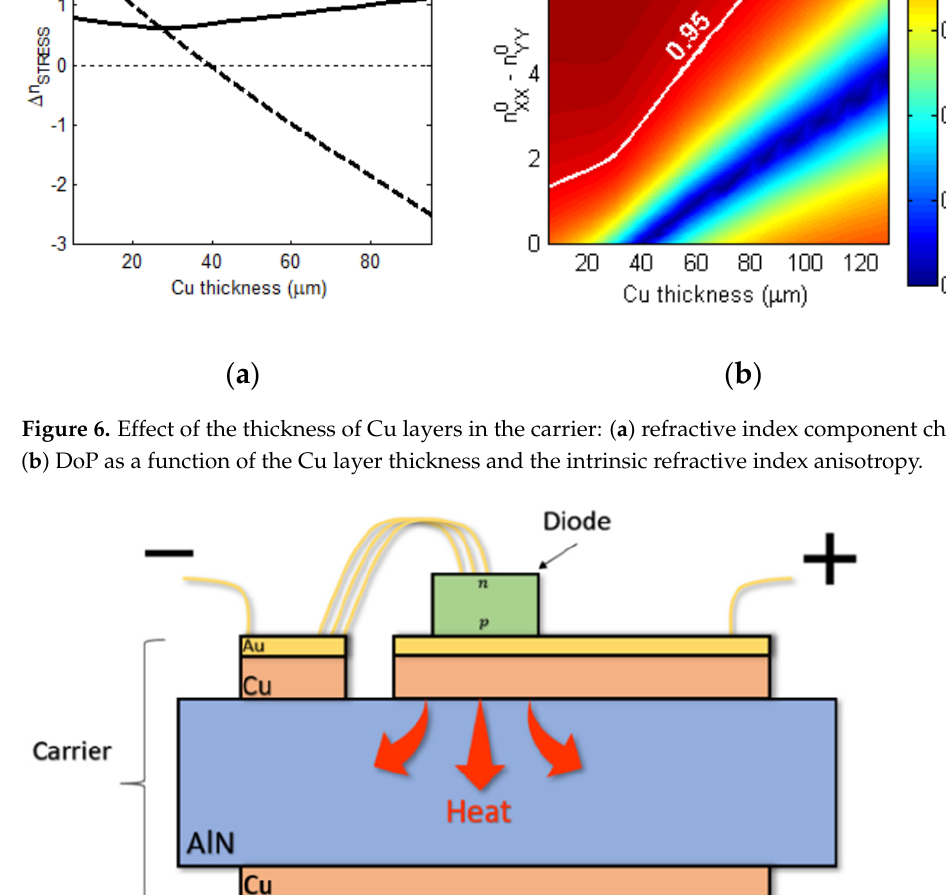
Figure 7. Schematic of a HPLD mounted on a carrier embedding Cu layers.